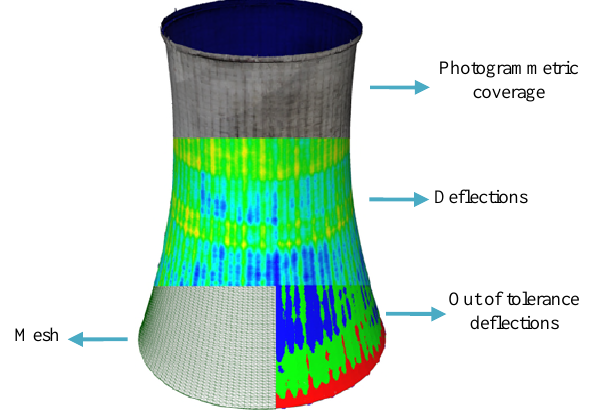
Figure 11. Representation of 3D model, deflections and photogrammetric coverage